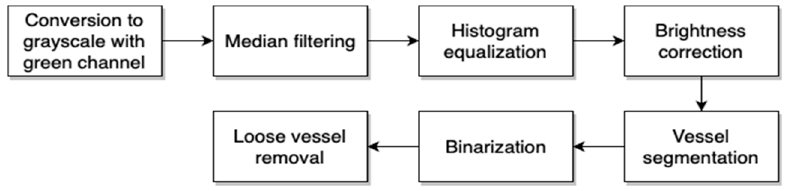
Figure 9. The block diagram of the proposed retina vascular pattern extraction.